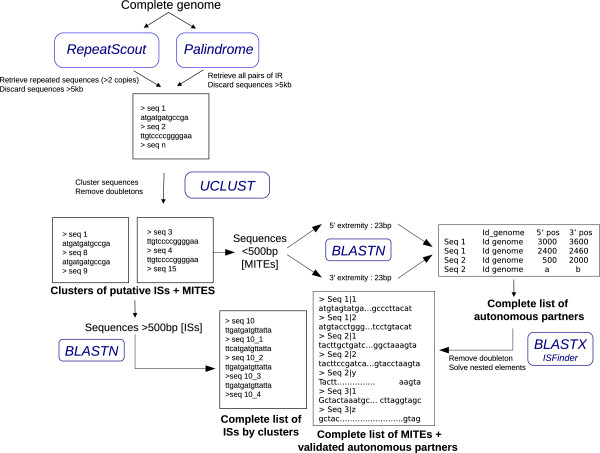
Simplified workflow of the de novo methods. Running softwares are indicated in blue, rectangles schematize the different output files at each step.